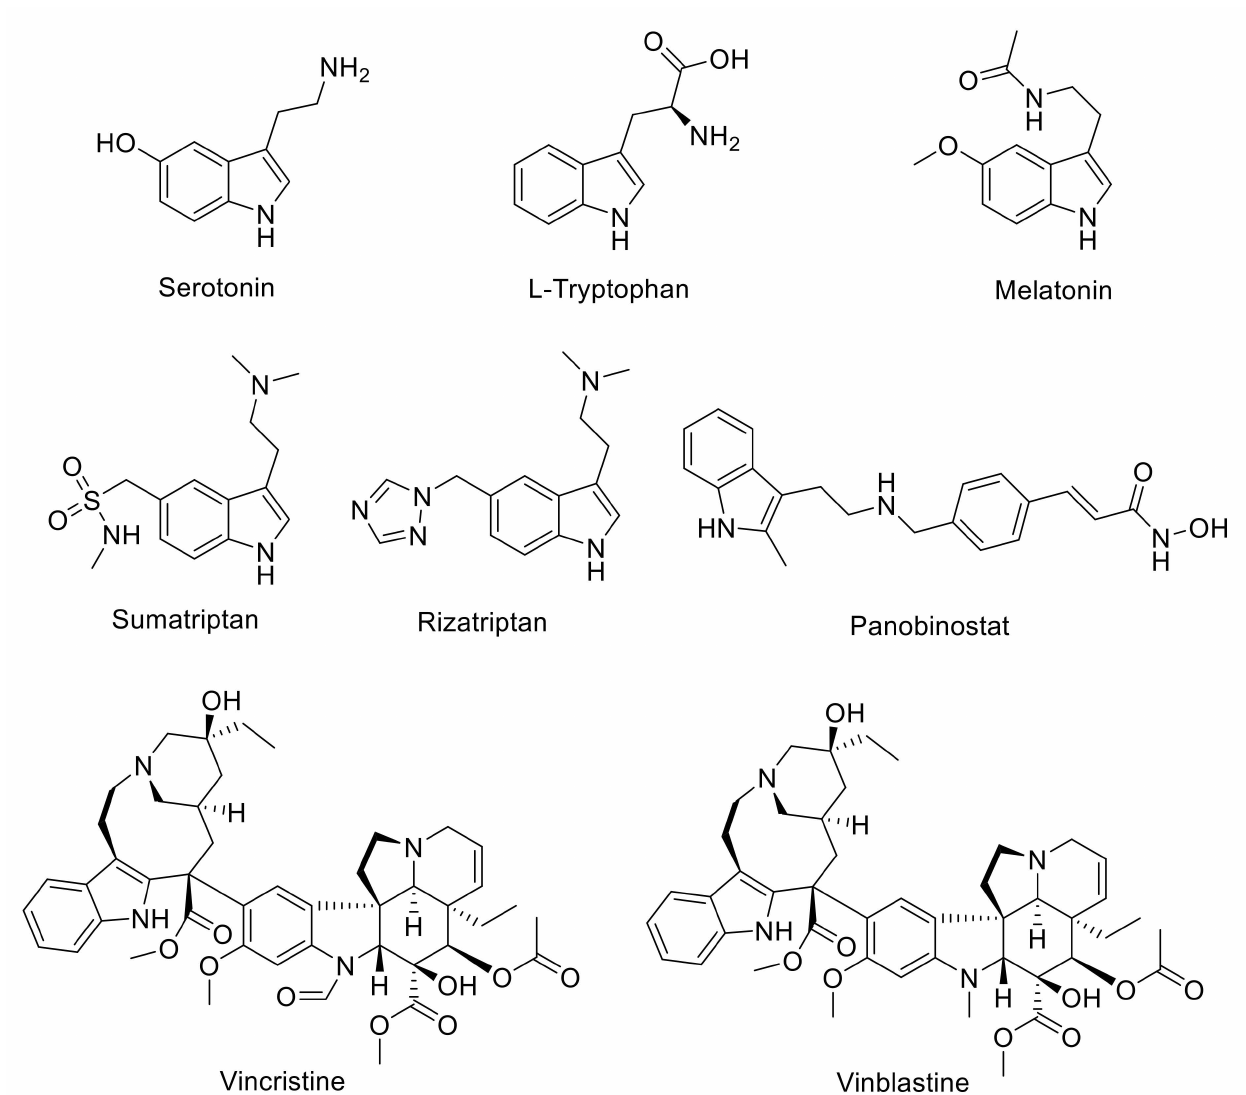
Figure 1. Natural products and pharmaceuticals containing tryptamine